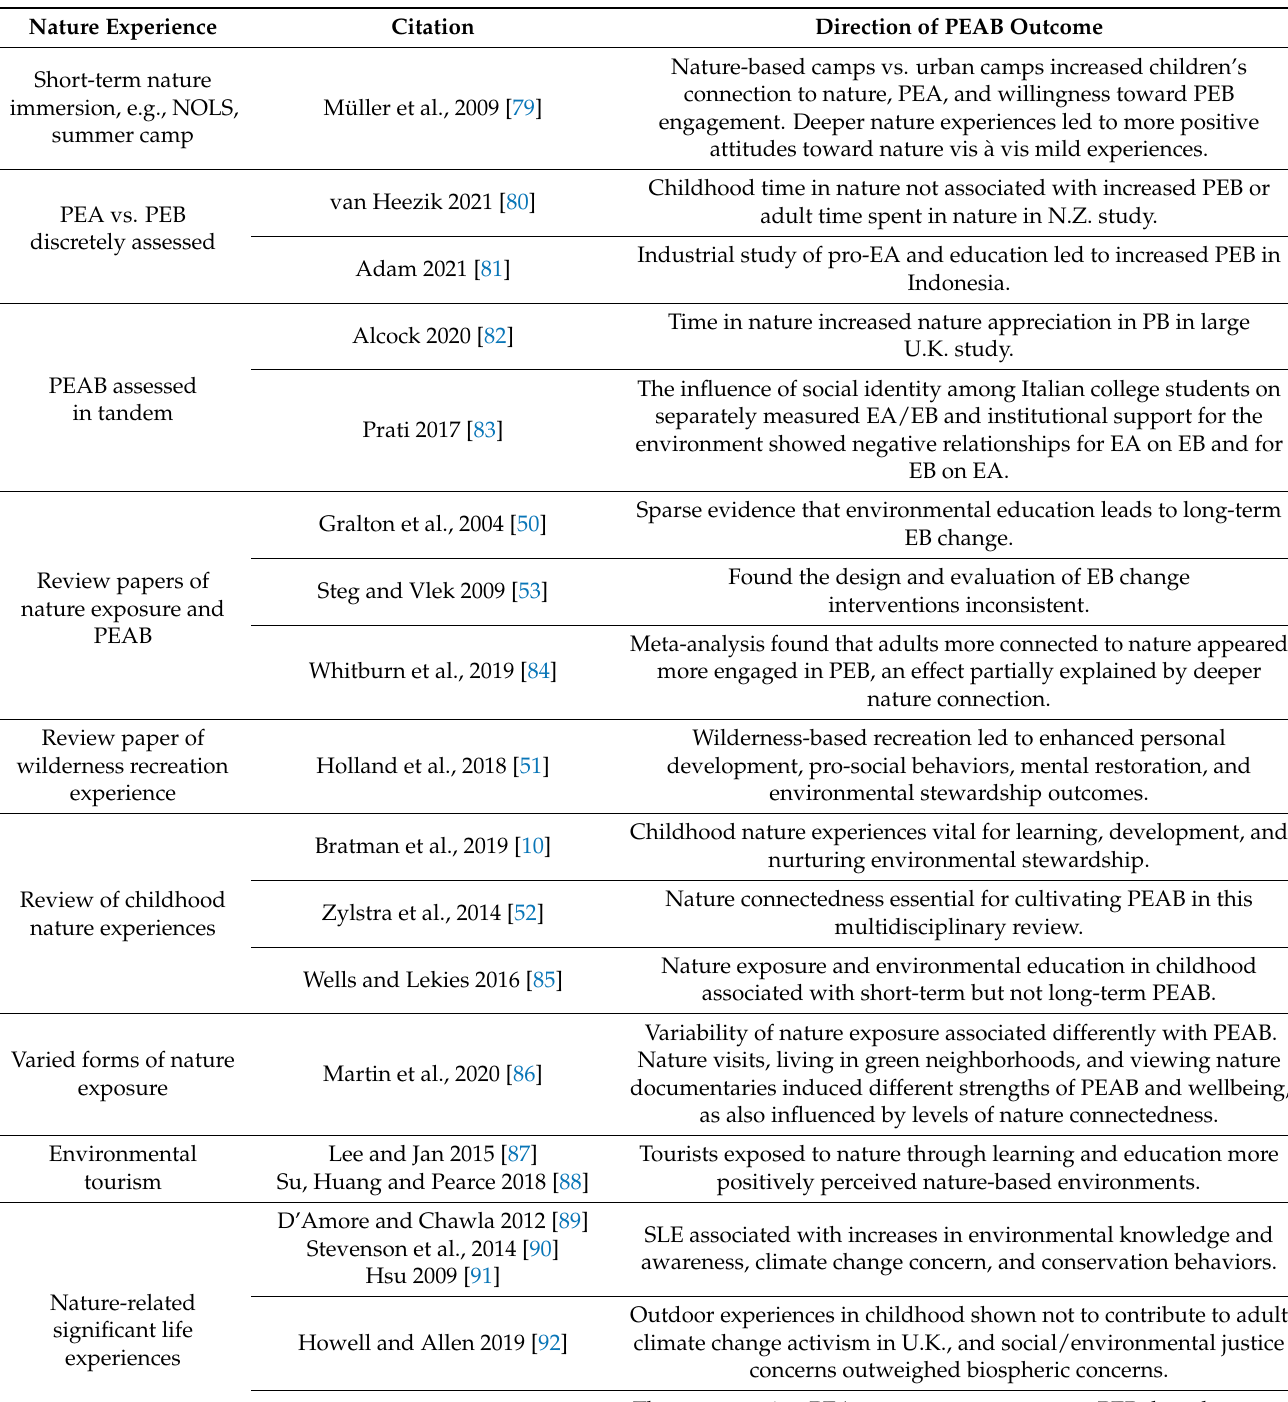
Table 3. Studies associating forms of nature exposure and experiences with PEAB